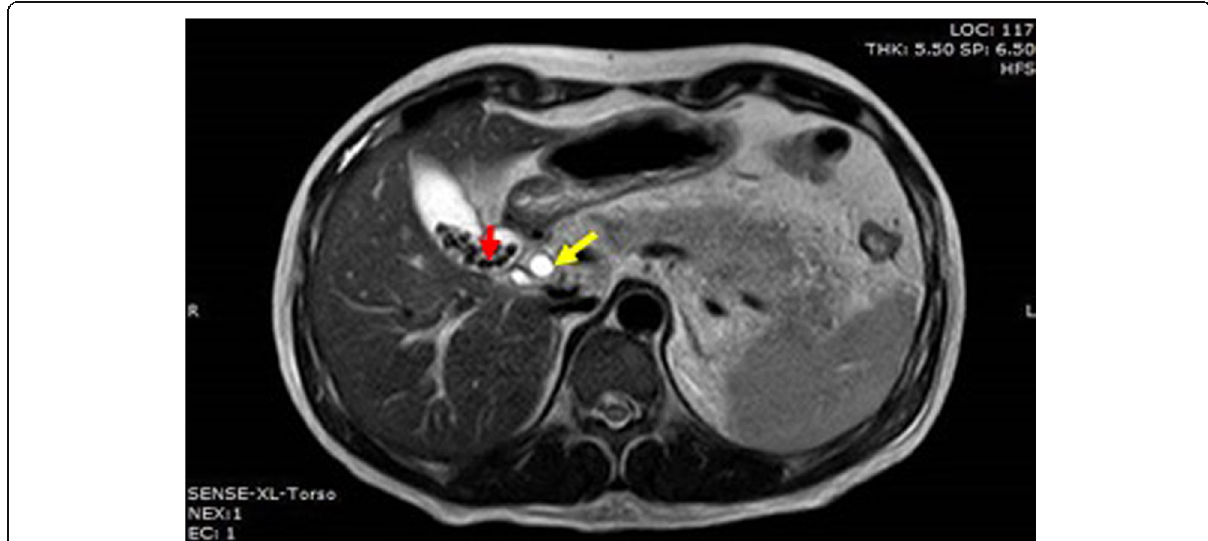
Fig. 4 Axial T2WI shows calcular gallbladder (red arrow) with dilated CBD (yellow